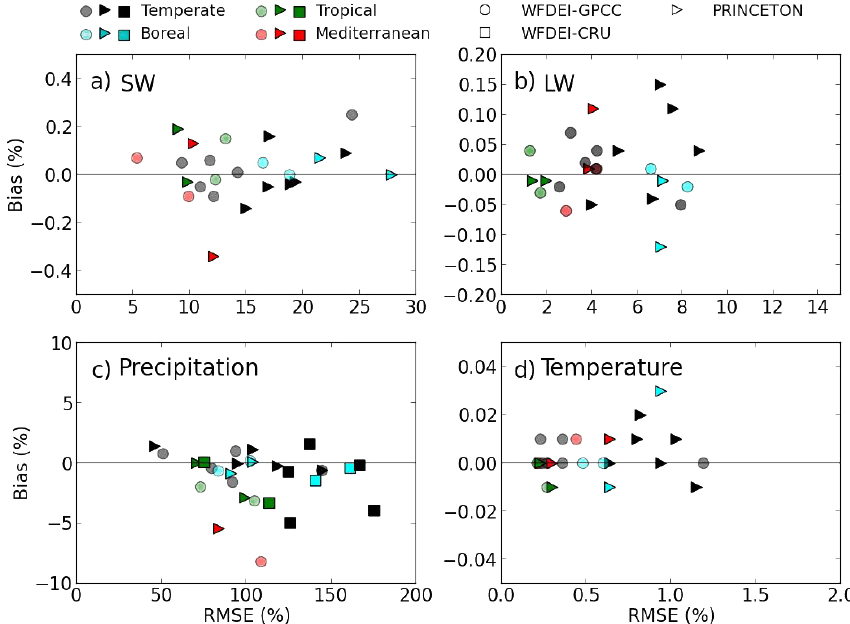
Figure 4. Bias and RMSE, expressed as percentages of daily average, when comparing global (WFDEI-GPCC (circles), WFDEI-CRU (squares) and PRINCETON (triangles)) to local meteorological data for four meteorological variables: (a) downward short-wave radiation (SW); (b) downward long-wave radiation (LW); (c) precipitation; and (d) surface air temperature, at the 12 FLUXNET sites (HF: Harvard Forest; VA: Vaira Ranch; MM: Morgan Monroe; HY: Hyytiala; TH: Tharandt; TUM: Tumbarumba; ES: El Saler; FP: Fort Peck; KA: Kaamanen; S67: Santarem Km67; S83: Santarem Km83; BO: Bondville). The site labels are coloured according to their climate zone (Table 2). Note that before computing bias and RMSE, the meteorological data was normalised against the annual mean for each